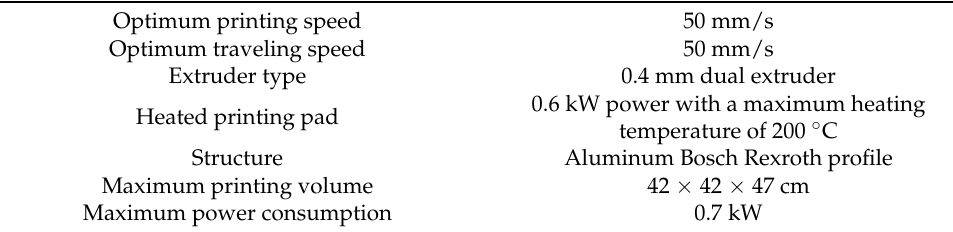
Figure 6. The Custom 3D Xcub printer employed for realizing the tensile test specimens. Table 2. Manufacturing characteristics of the Custom 3D Xcub 3D